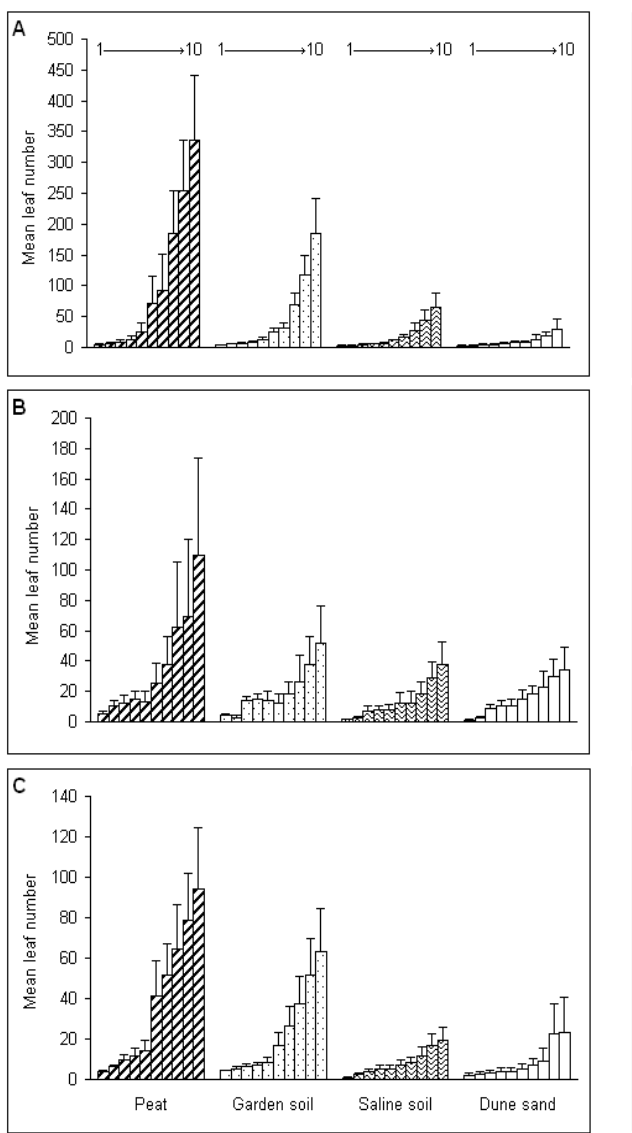
Fig. 2. Evolution of mean plant length (cm) of Inula crithmoides (A), Plantago crassifolia (B) and Medicago marina (C) plants, grown for 10 weeks on the indicated types of